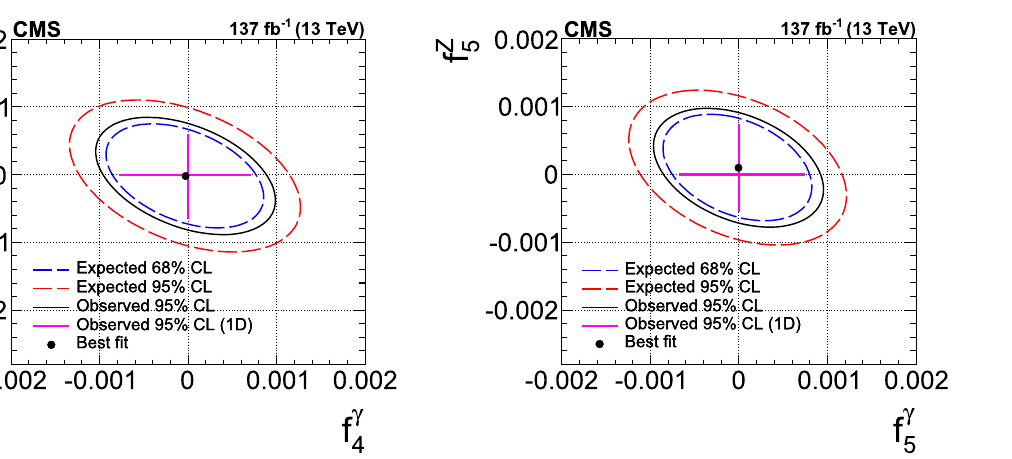
reach their maximum. The coupling values outside the contours are excluded at the corresponding confidence level. The crosses in the mid- dle represent the observed 1D limits. No form factor is used